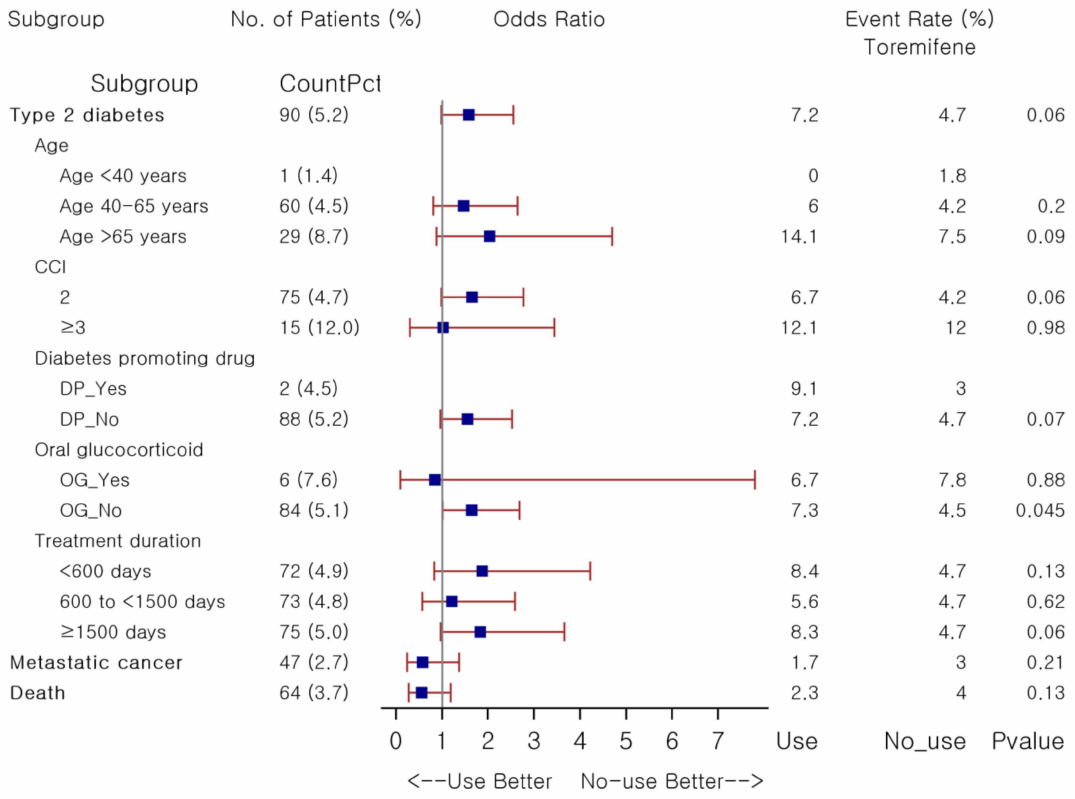
Figure 3. Forest plot for association between study outcomes and toremifene in female patients with breast cancer. Abbreviations: CCI, Charlson Comorbidity Index; DP, diabetes promoting; OG, oral